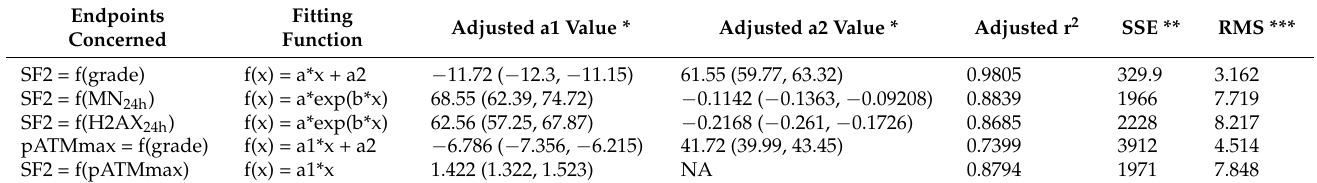
Table 1. Fitting parameters for the relationships between the radiosensitivity